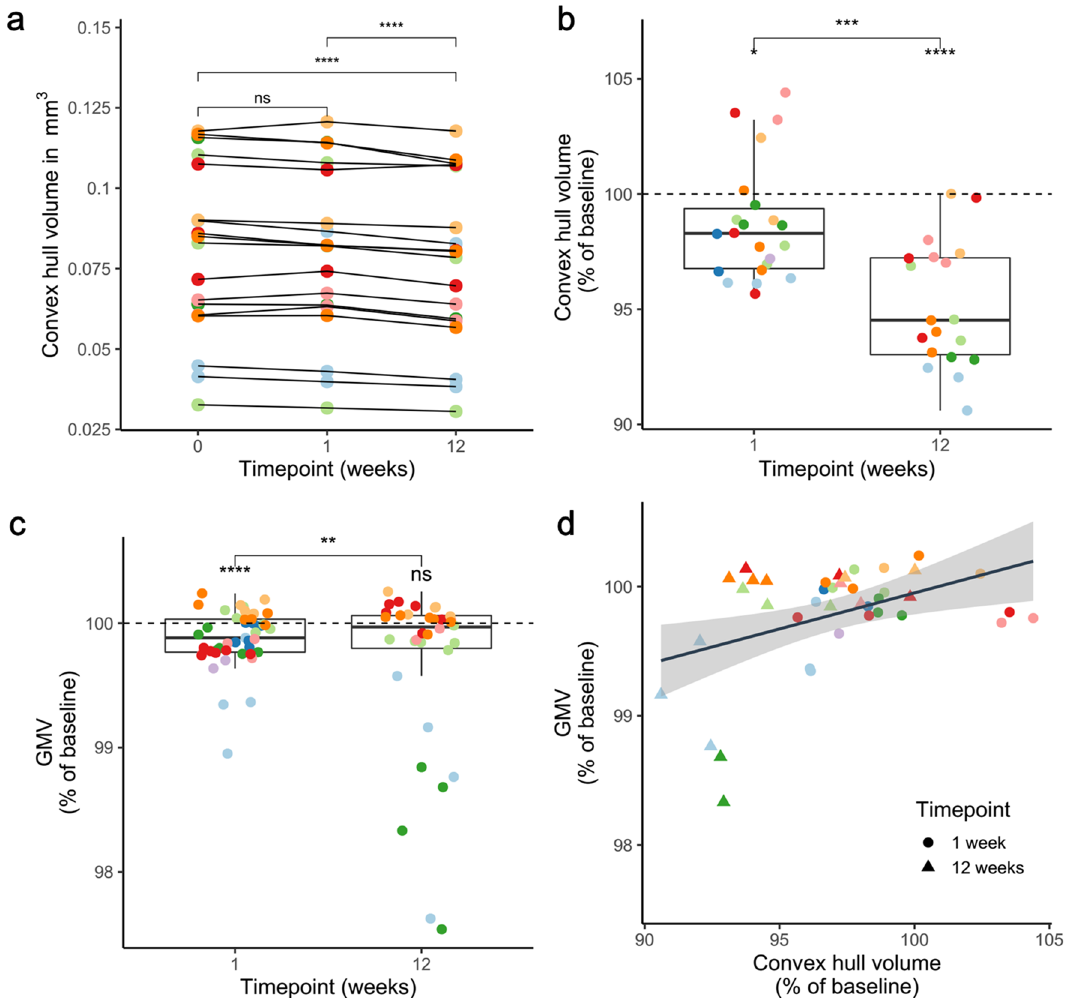
Figure 6. Correlation of tissue volume with GMV. Colours of plotted datapoints denote individual mice. ( a ) Volumes of convex hulls in 2Pii stacks significantly shrink over time. Display of all measured absolute volumes. Repeated measure one-way ANOVA with complete datasets (all timepoints available) of n = 18 positions of 7 mice, F = 29.12, DF = 2, p = < 0.0001. Post-hoc Tukey test for multiple comparisons with adjusted p values: 0 vs. 1 week: p = 0.260; 0 vs. 12 weeks: p < 0.0001; 1 vs. 12 weeks: p < 0.0001. ( b ) Relative change in 2Pii convex hull volumes compared to baseline (= theoretical mean of 100%) at 1 week and 12 weeks. In addition to Fig. 6A, also datapoints with missing values for the 12 weeks timepoint are included. At 1 week: n = 22 positions of 9 mice, mean ± SD = 98.74 ± 2.55%; Wilxocon signed rank test gives p = 0.046. At 12 weeks n = 19 positions of 7 mice, mean ± SD = 95.16 ± 2.71%, Wilxocon signed rank test gives p < 0.0001; linear mixed effect model for difference between 1 and 12 weeks: p < 0.0001. ( c ) Changes of GMV in MRI masks of 2Pii stacks. Wilxocon signed rank test at 1 week gives mean ± SD = 99.87 ± 0.24%, p < 0.001, n = 45 positions of 9 mice; at 12 weeks: mean ± SD = 99.67% ± 0.71%, p = 0.075, n = 35 positions of 7 mice. Linear mixed effect model for difference 1 week and 12 weeks: p = 0.008. ( d ) Microscopic volume changes correlate with GMV in MRI masks. Linear mixed effect model with p = 0.014, Estimate = 0.046%, R 2 = 0.130, n = 41 (22 positions of 9 mice at 1 week, 18 positions of 7 mice at 12